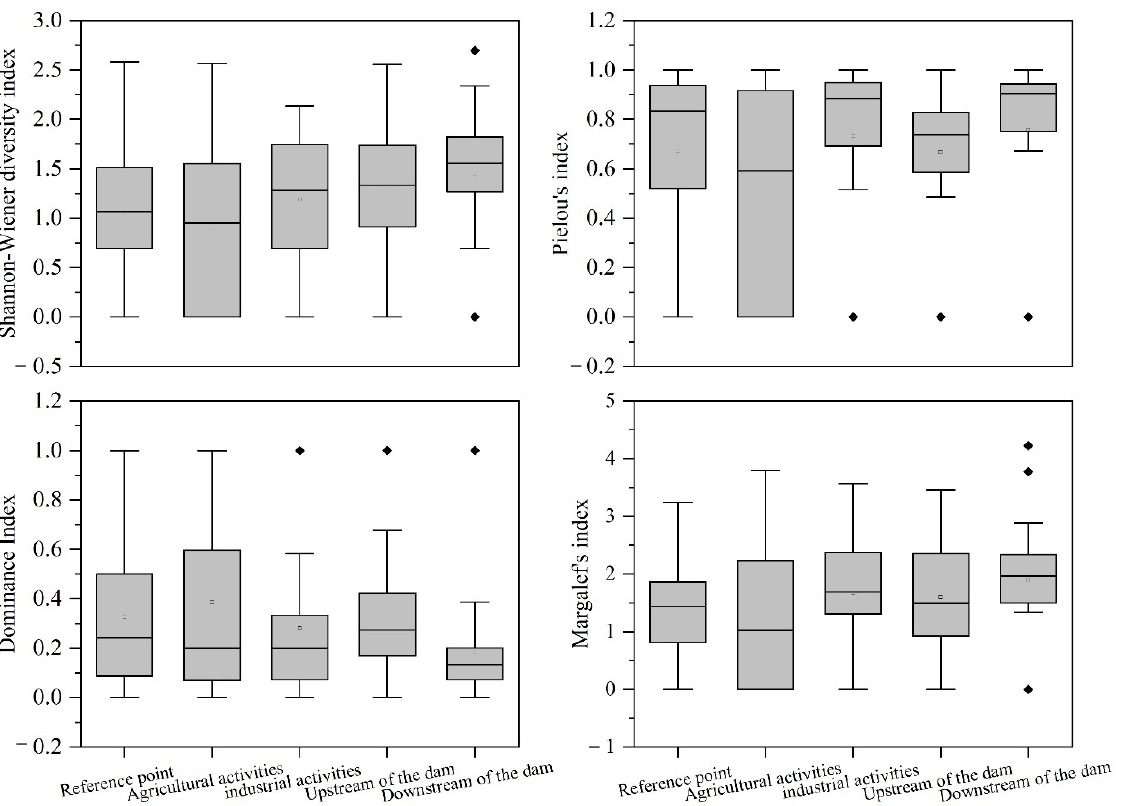
Figure 3. Zooplankton diversity in different areas of the Wanan River basin, China.